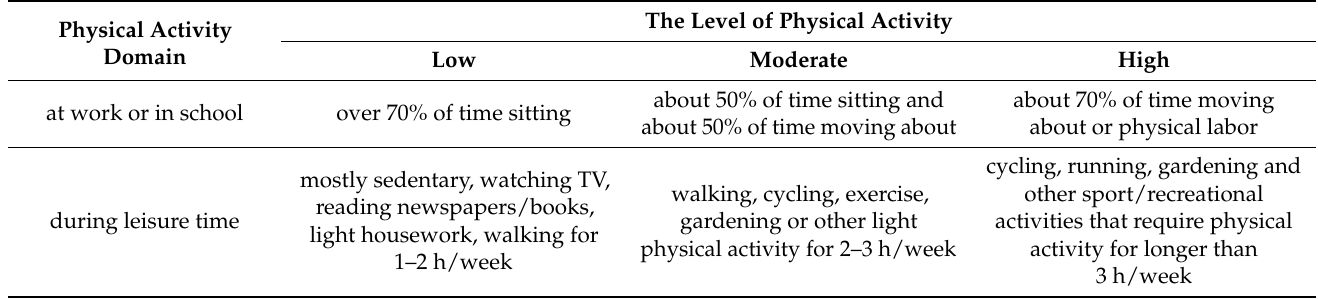
Table 2. Physical activity assessment based on the KomPAN questionnaire